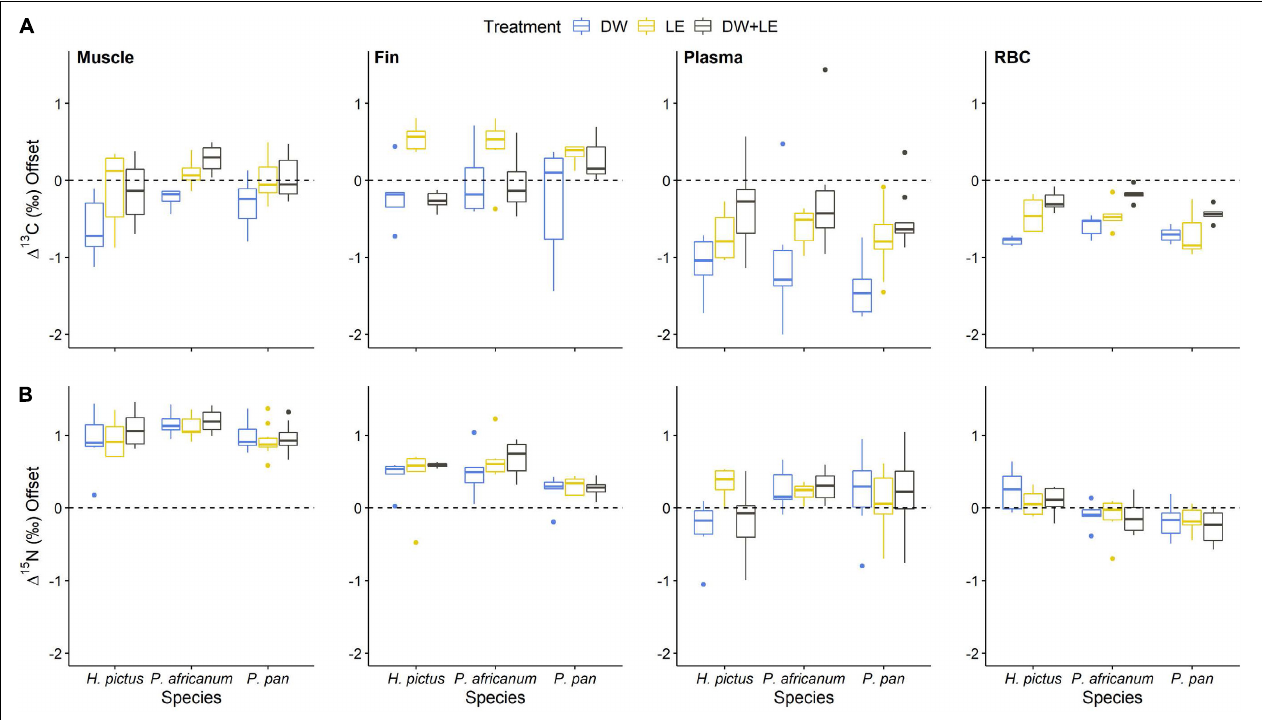
FIGURE 2 | (A) (cid:49) 13 C and (B) (cid:49) 13 C offsets for all treatments in muscle, fin, plasma, and RBC across the three shark species. Single-colored points indicate offsets are outside of the grouped range. Boxes display median values (horizontal line) with upper and lower quartile ranges (upper and lower end of box), and maximum and minimum values (whiskers). P. pan, P.